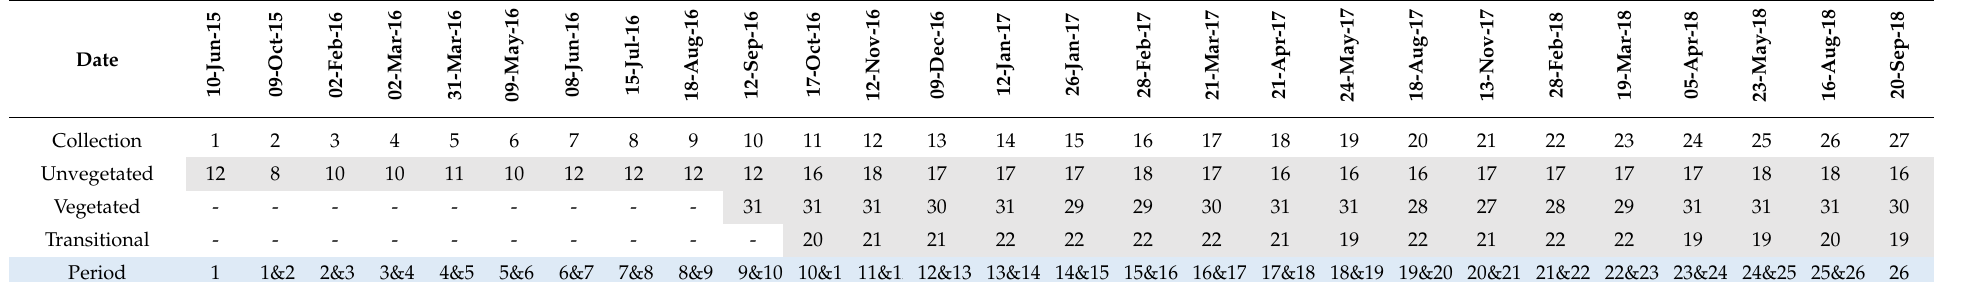
Table 1. Dates of all 27 total collections for the elevation pin types installed throughout the IBSP foredunes. The number in each cell represents the sample size of each period reflecting pins going missing or becoming buried between collections. Blue cells denote the period number, ∆ z from one collection to the next, where period one is ∆ z between collections one and